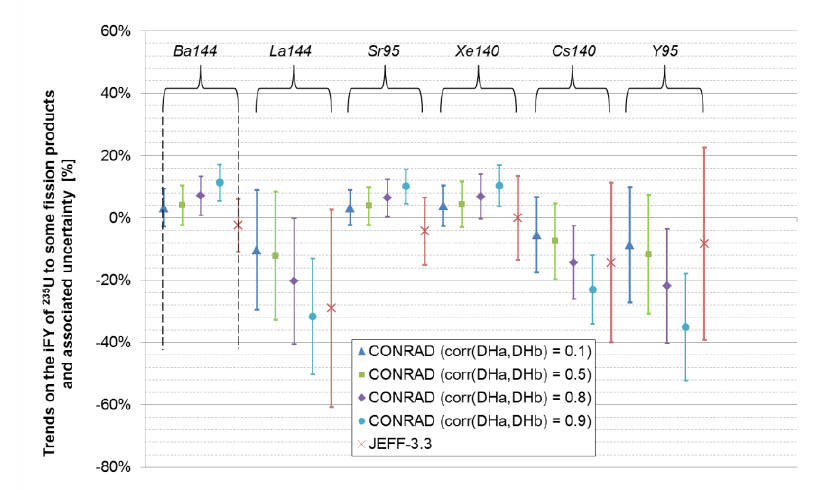
Fig. 5. Assimilation of nine correlated MERCI-1 experimental values (with different